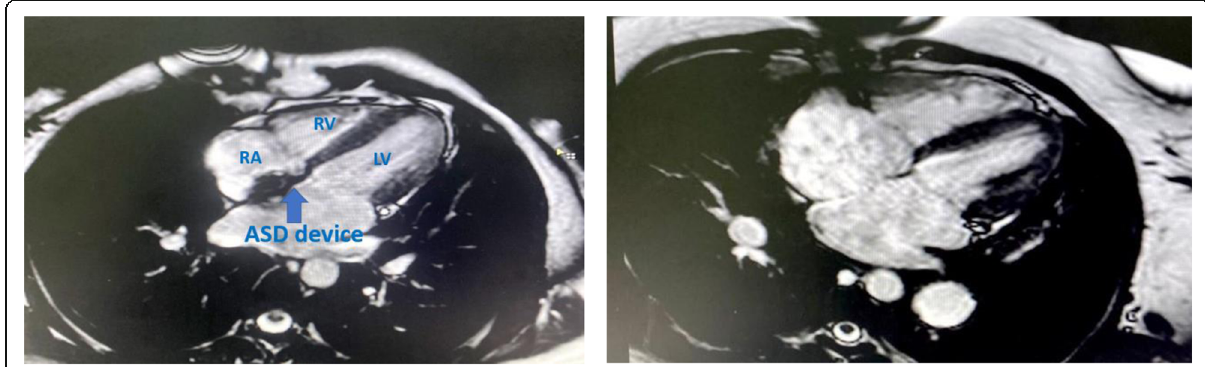
Fig. 6 Cine SSFP 4 chamber MRI view in transcatheter closed case by